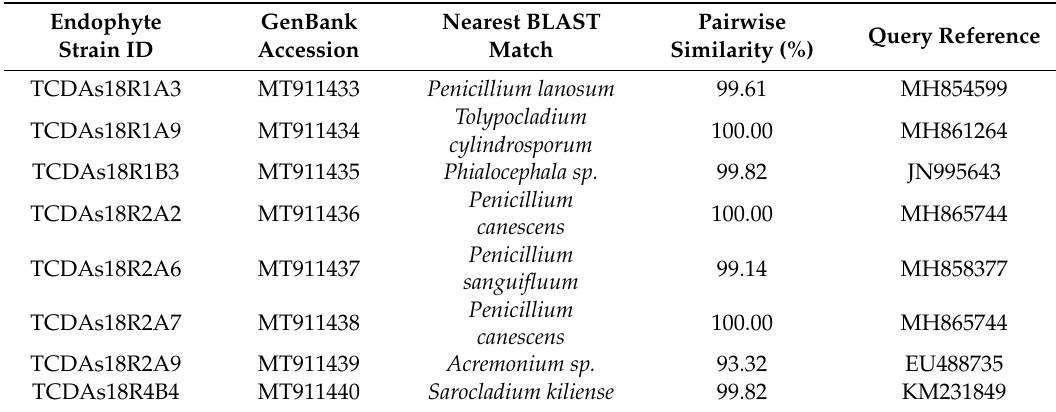
Table 1. Identification summary of the experimental fungal endophyte strains. nrITS gene sequences of the isolates were compared using BLAST to those in the GenBank and UNITE databases.